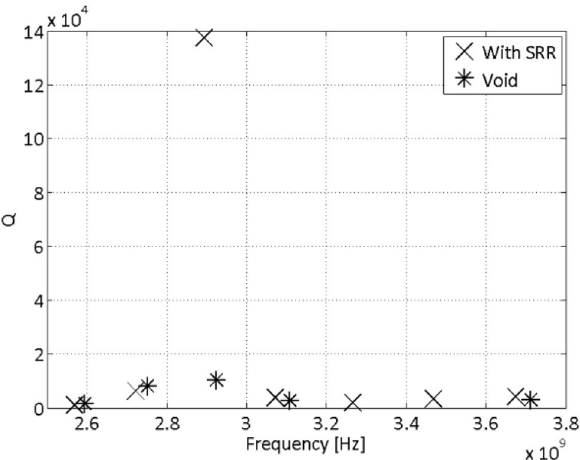
Figure 5. Measured unloaded quality factors (Q) with and without SRR